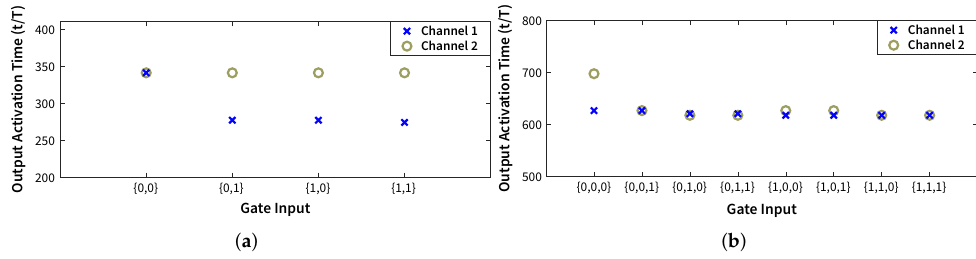
Figure 17. Activation time of the output channels for the ( a ) 2-input NOR chemical logic gate and the ( b ) 3-input OR chemical logic gate